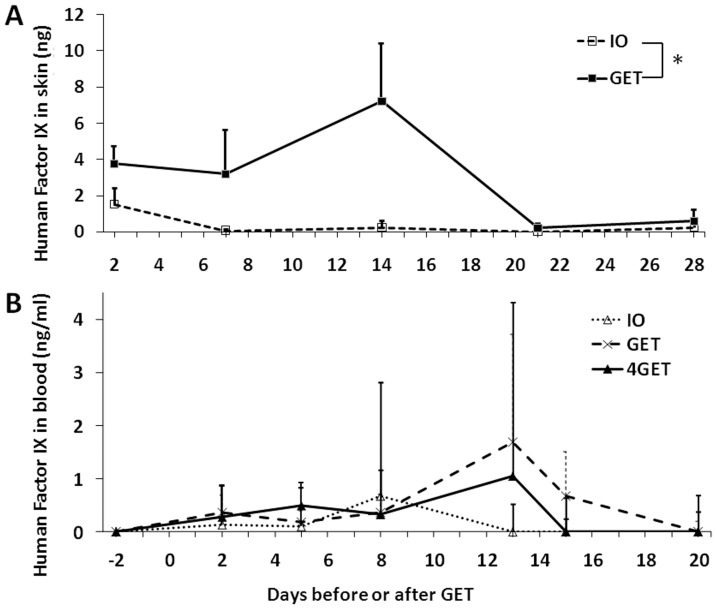
Human factor IX protein in HLGP after i.d. DNA (pNGVL3/CMVi/hFIXm1) injection and non-invasive GET.
A, Human factor IX in HLGP skin. Delivery groups, IO: 50 µL DNA without pulse delivery; GET: 50 µL DNA with 1 pulse delivery on the injection site. Bars represent mean ± SD. 3 sites were analyzed for each delivery. * p<0.05 by Student's t-test. B, Human factor IX in HLGP plasma. Delivery groups, IO: 50 µL DNA without pulse delivery; GET: 50 µL DNA with 1 pulse delivery on the injection site. 4GET: 4×50 µL DNA with 4 pulse delivery on the injection site. Bars represent mean ± SD. 4 HLGPs were analyzed for each delivery group.